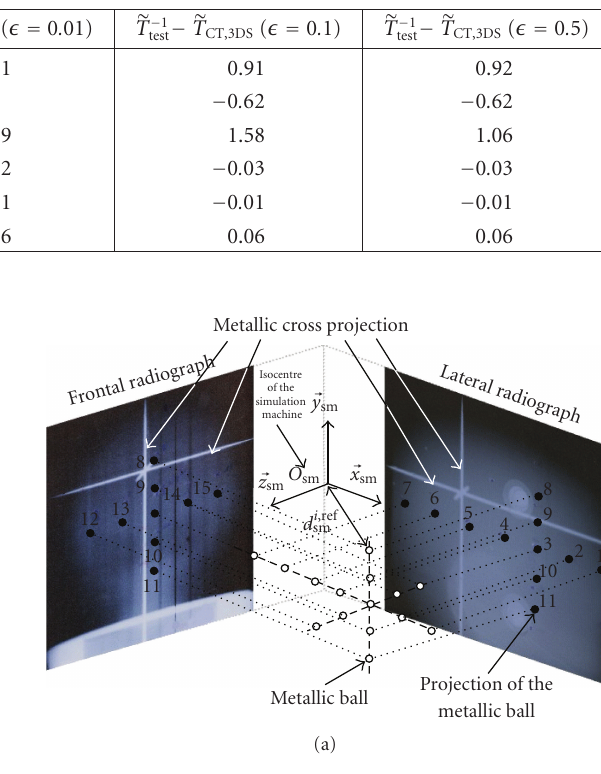
Tests were performed with a plaster head acting as phan- tom (see Figure 5). Fifteen metallic balls (simulating tumors) were included in the head. These radio-opaque balls, with a mean diameter of 5 mm, were regularly spaced and placed exactly on three orthogonal axes. Figure 6(a) gives the labels of these balls. It is noticeable that the balls are distributed into the whole head volume so that it can be checked if the positioning accuracy depends on the tumor